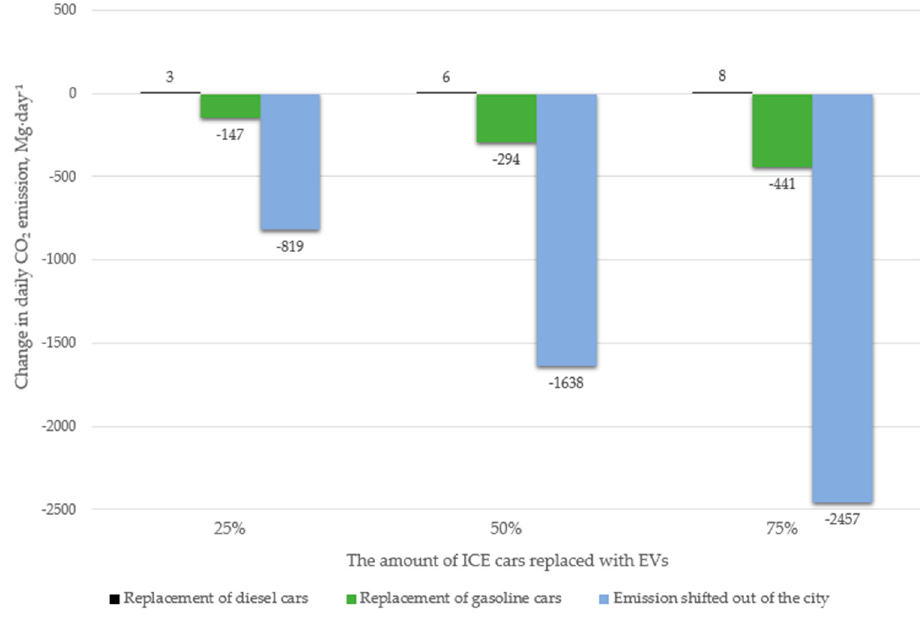
Figure 6. Change in daily CO 2 emissions as a result of replacing ICEs with EVs.